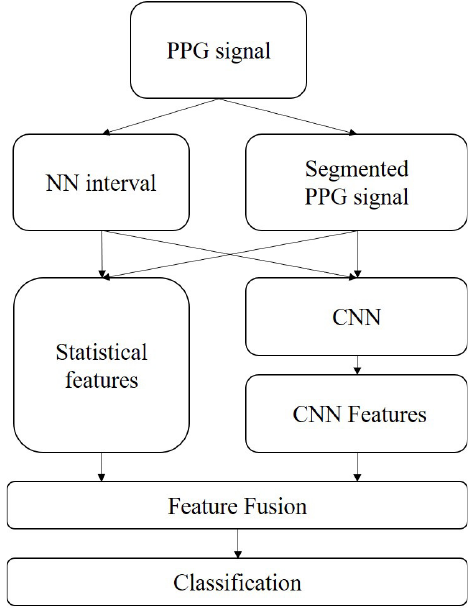
Figure 2. Emotion recognition model architecture. NN, normal-to-normal.